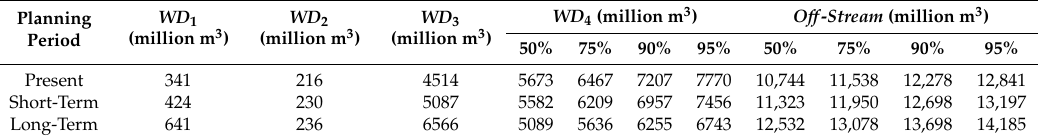
Table 3. Future annual off-stream water demand projection for the middle and lower reaches of Hanjiang River basin at present and two planning